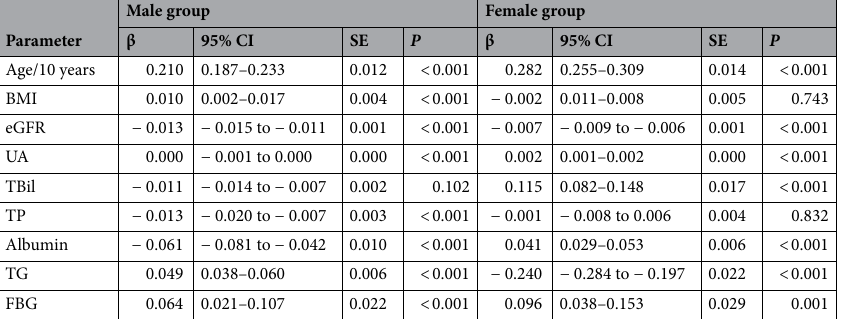
Table 3. Multiple linear regression analysis for the association between BUN and clinical variables in males and females population. BMI: body mass index; eGFR: estimated glomerular filtration rate; SE: standard error; UA: uric acid; TBil: total bilirubin; TP: total protein; TC: triglyceride; FBG: fasting blood